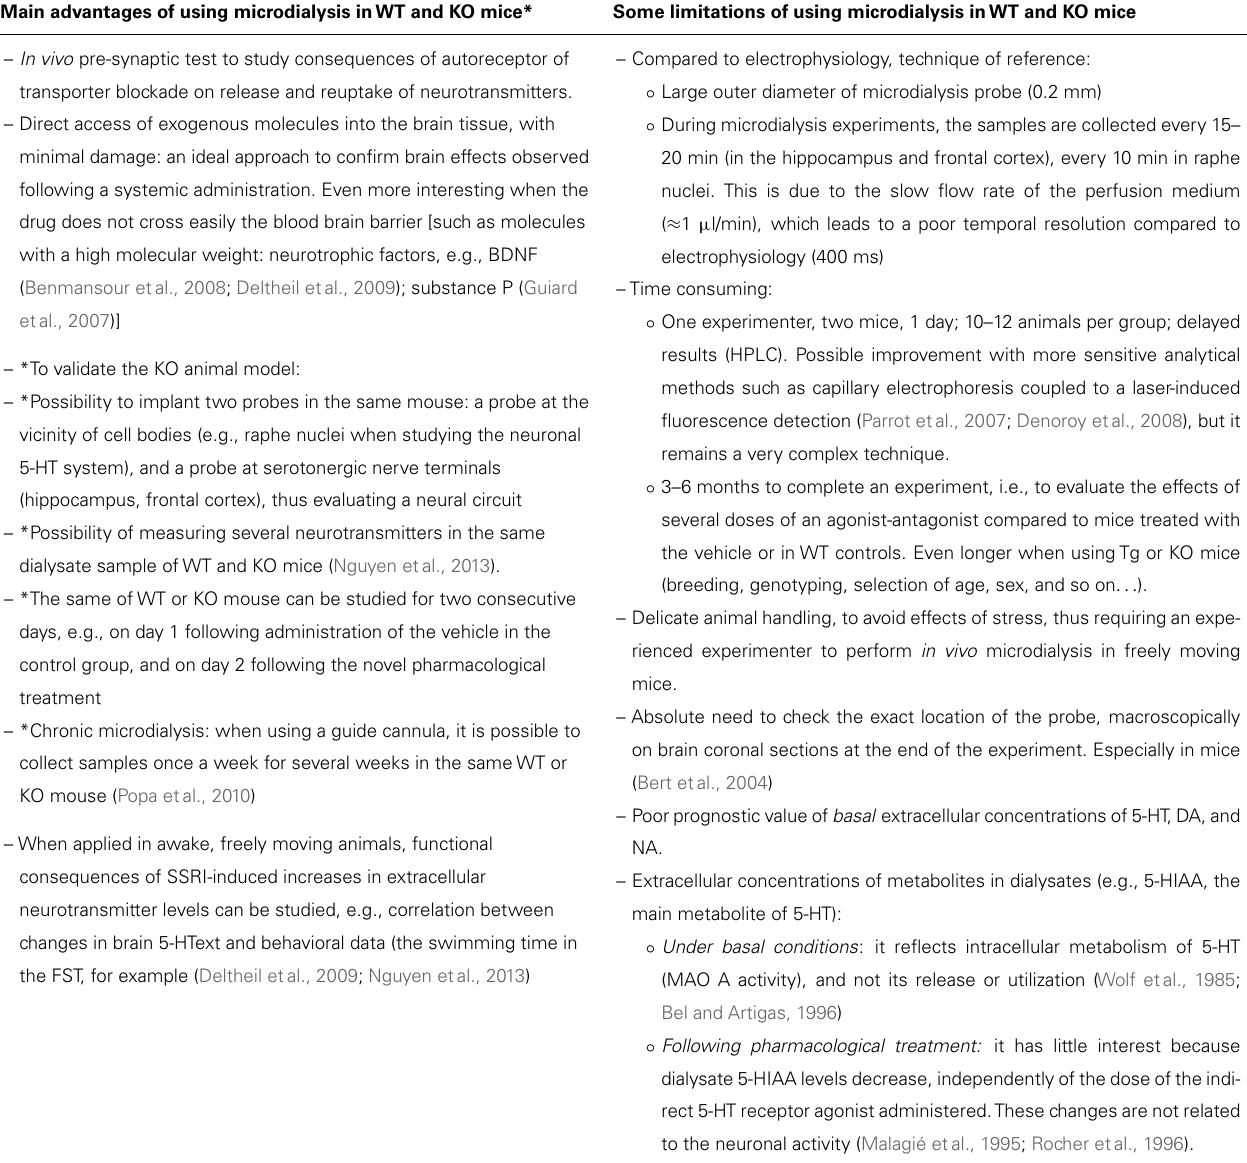
Table 1 | Summary of the main advantages and some critical points of the intracerebral microdialysis technique in freely moving mice. Main advantages of using microdialysis inWT and KO